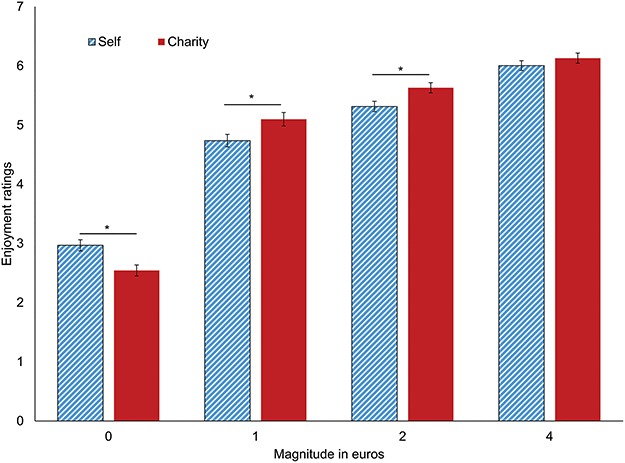
Bar chart representing winning enjoyment for different beneficiaries and magnitudes. Enjoyment is plotted on the y-axis (scale ranged from 1 to 7) and different sets of bars represent different magnitudes (€0, €1, €2, €4). Blue-colored bars represent outcomes for self, red-colored bars represent outcomes for charity. Differences significant at P < 0.05 are flagged with ‘*’.